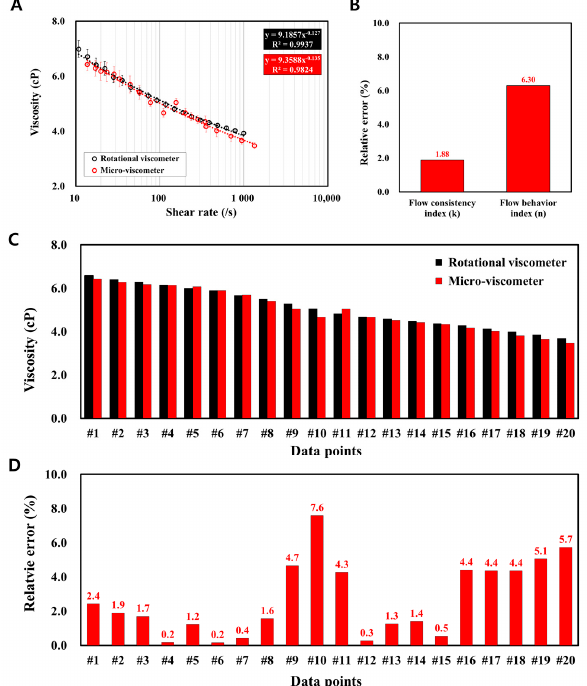
Figure 5. Experimental reliability test of the micro-viscometer. ( A ) Repeated viscosity measurements were performed (N = 7) with the proposed micro-viscometer. Each measurement provides very similar results (averaged standard deviation of 4.25% for seven sets of viscosity measurements). The result also shows a very similar shear-thinning viscosity of the blood compared to the result from the rotational viscometer. ( B ) Relative errors for the two indices (k and n) are 1.88% and 6.30%, respectively. ( C , D ) According to the t -test, there are no statistically significant differences (p > 0.05) for 14 data points, and the averaged relative error is 1.56%. Although the remaining six data points show a significant difference (p < 0.05), the averaged relative error is 5.35%. This implies that the micro-viscometer shows reliability in repeated viscosity measurements.